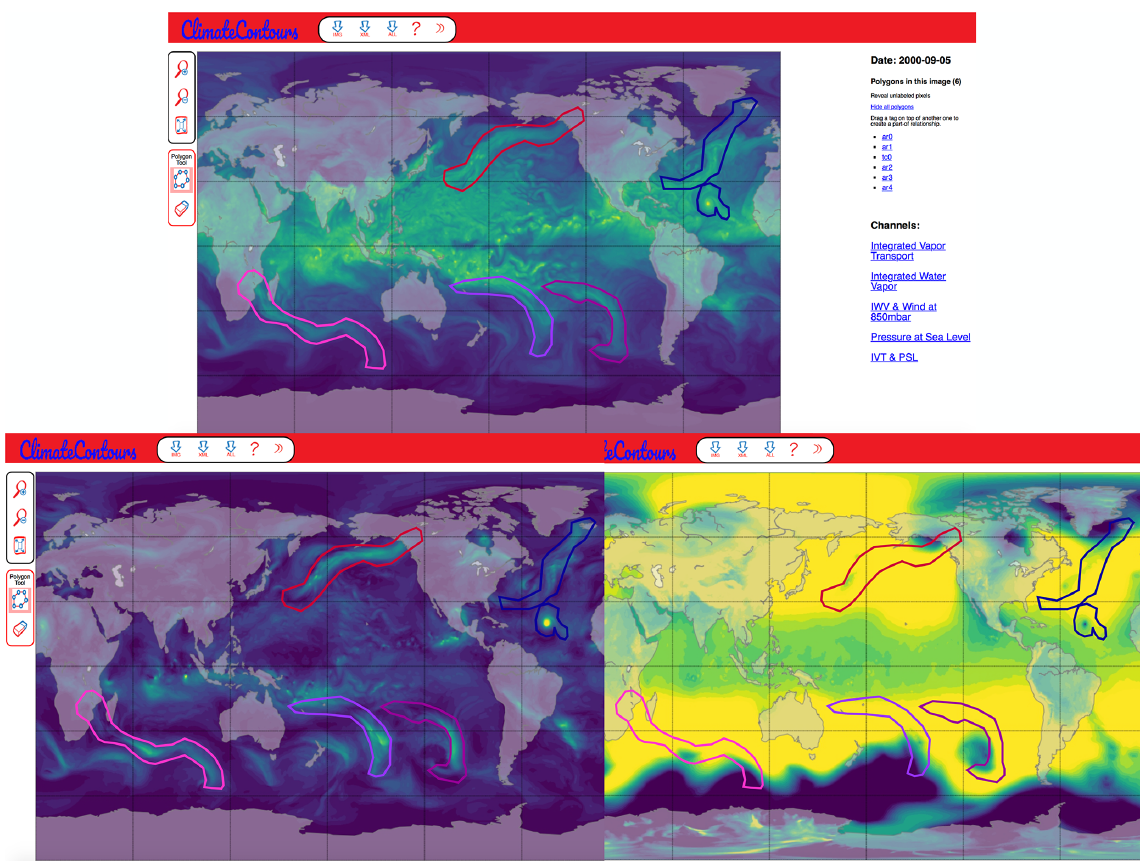
Figure 1. The ClimateContours web-based labeling interface. Labelers can choose different channels (physical variables) on the right side of the GUI to display different variables or combinations of variables on the global map. On top: integrated water vapor (IWV) is shown with labels of ARs and TCs; bottom left: integrated vapor transport (IVT); bottom right: pressure at sea level